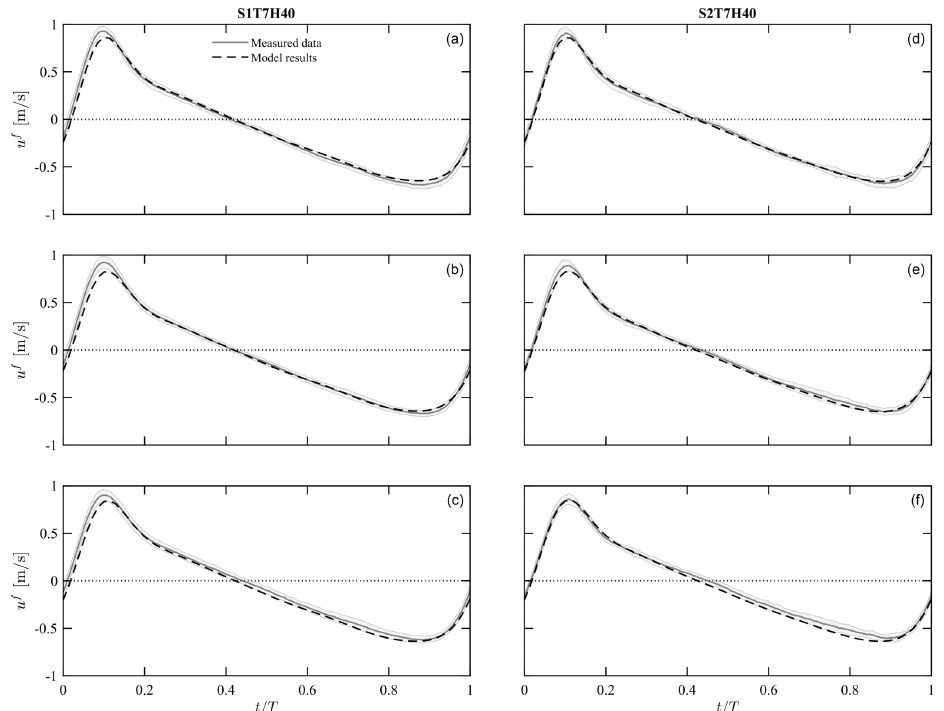
Figure 4. Time series of streamwise fluid velocity, u f ( x , z , t / T ) , for measured data (gray solid curves, phase-averaged; gray envelopes, ± 1 standard deviation) and model results (black dashed curves) at x = 0. The vertical elevations were ( a ) z = 0.516 m, ( b ) z = 0.315 m, and ( c ) z = 0.121 m for S1T7H40, and ( d ) z = 0.511 m, ( e ) z = 0.310 m, and ( f ) z = 0.116 m for S2T7H40.